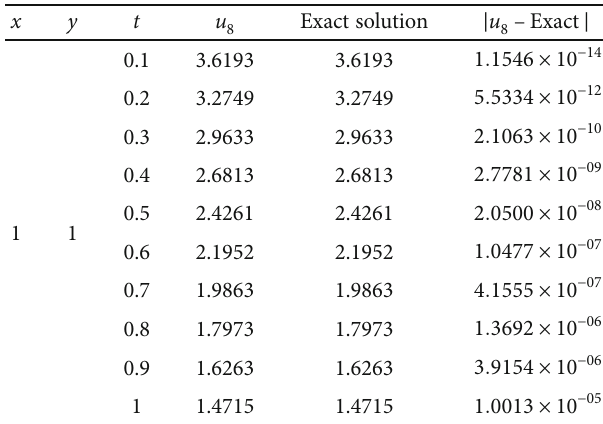
Table 3: Eighth-order approximate solution by RDTM of Example 2 for di ff erent values of t and comparison with the exact